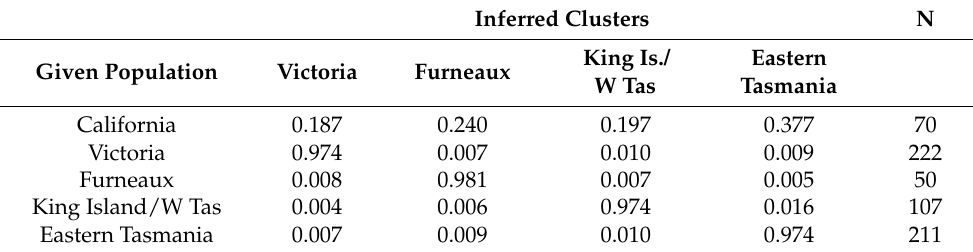
Table 1. Average probability of assignment of samples from the Californian landrace to the four major regions in the native range of Eucalyptus globulus , based on six nuclear SSRs, and the number of samples in each pre-defined group (N). Seventy Californian samples were assigned to four pre- defined regions of the native distribution in Australia (Figure 3), using STRUCTURE. The assignment of the 590 native E. globulus samples used to define a priori the regional groups in the STRUCTURE analysis is also shown (W Tas = western Tasmania).